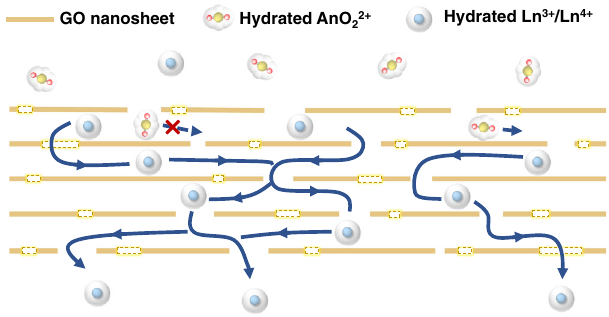
Fig. 5 | Sectional view of possible permeation routes for lanthanides/actinides by ion sieving in GOM. The dotted squares represent the pinholes on the GO sheets. The arrows show the possible permeation routes in the GOM.